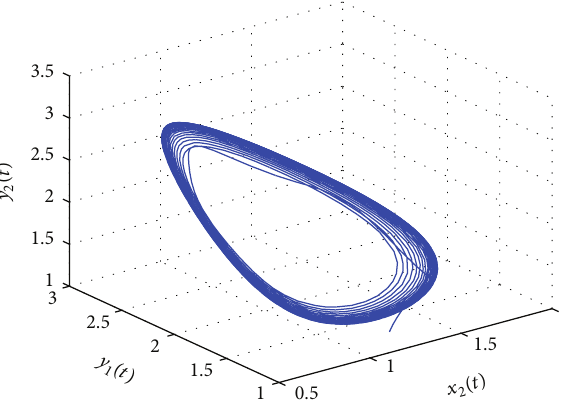
Figure 17: The phase plot of the states 𝑥 1 , 𝑥 2 , 𝑦 2 for 𝜏 = 3.2500 > = 3.1043 . 𝜏 0